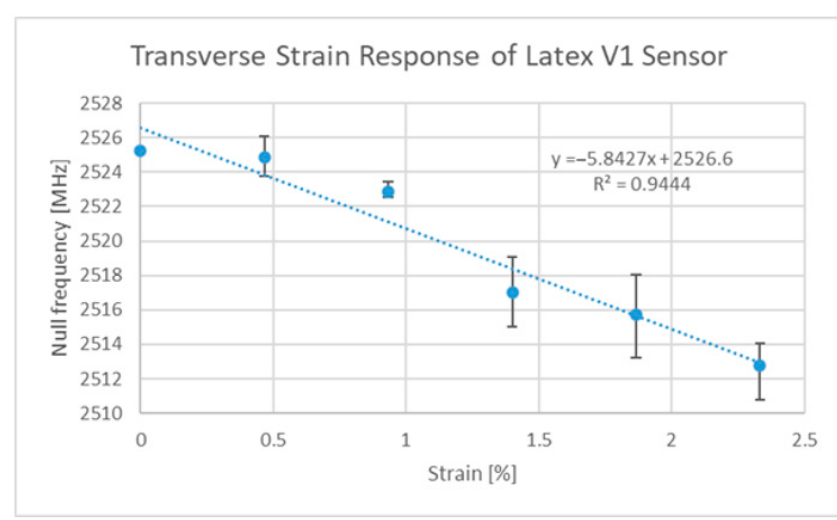
Figure 9. Latex V1 axial strain sensitivity curve.